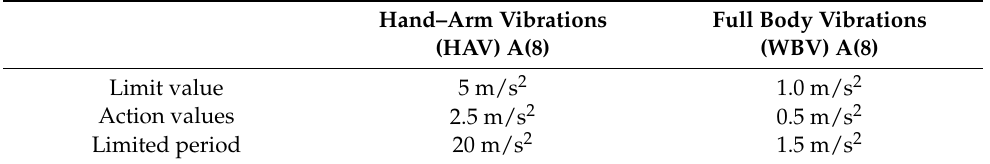
Table 1. Limits established by law 81/08 after 2002/44/EC